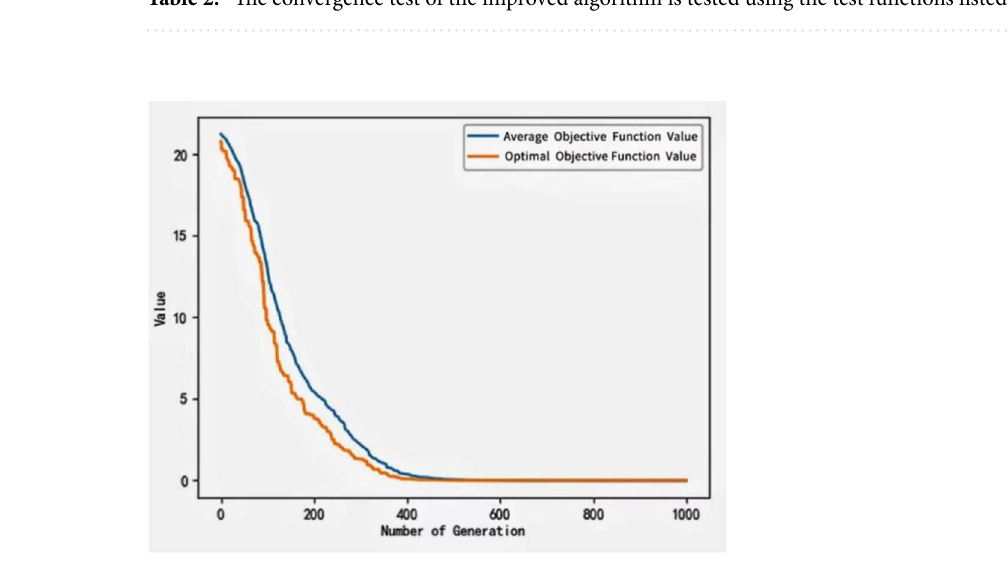
Figure 8. Convergence curve of the improved algorithm tested with Ackley’s